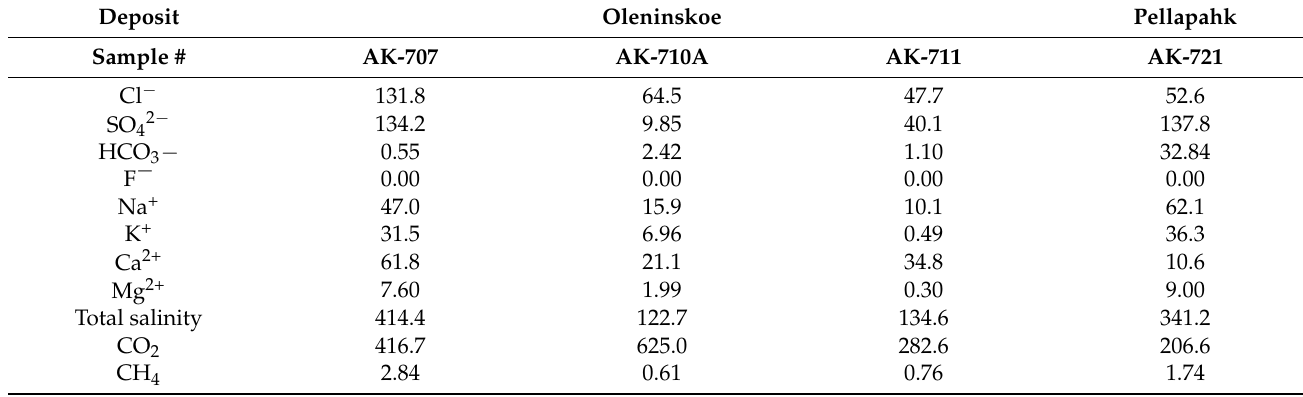
Table 8. Concentration of the main components in fluids from the Oleninskoe and Pellapahk deposits, g/kg H 2 O